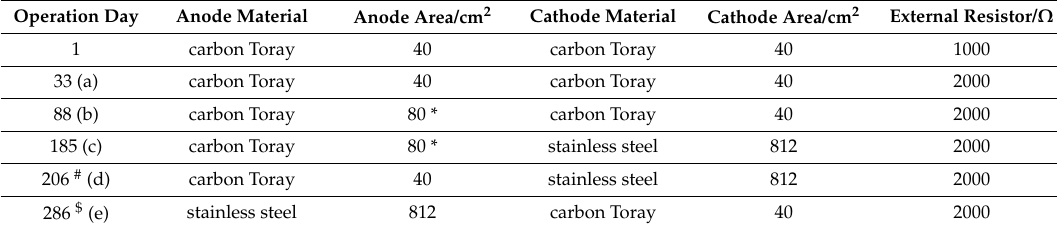
Table 1. Summary of electrode materials and configurations tested during the assay.